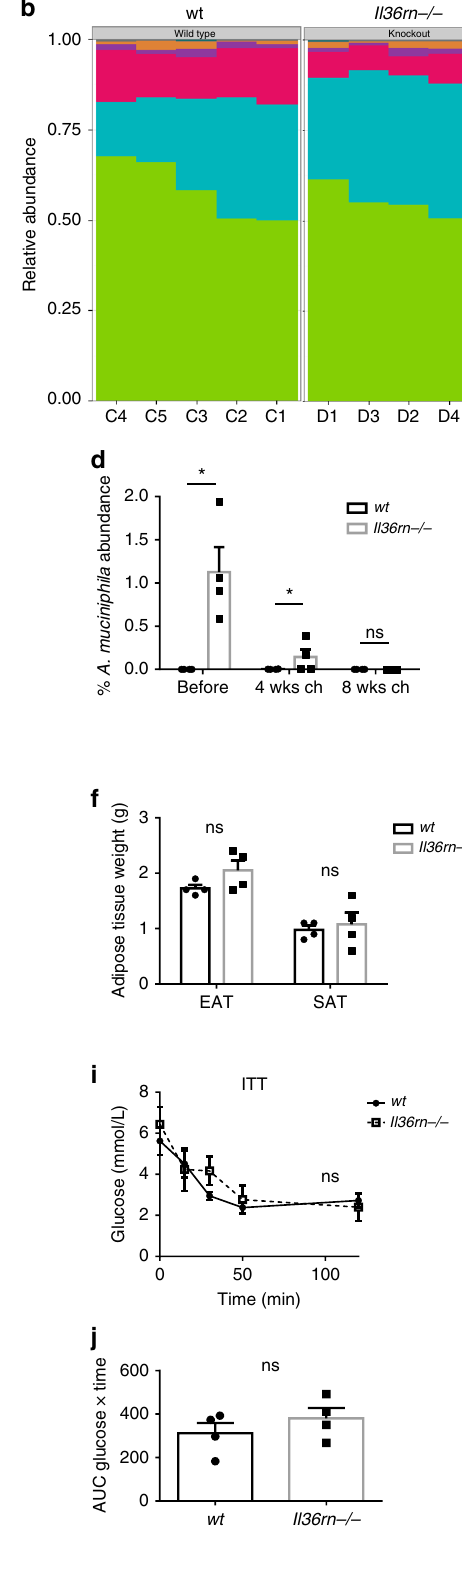
correlated with primary indicators of metabolic health, i.e. HbA1c and FBG levels, among obese patients presenting with diabetes, indicating that elevated IL-36 cytokines may play a protective role in reducing blood sugar levels among obese patients who have developed consequent metabolic